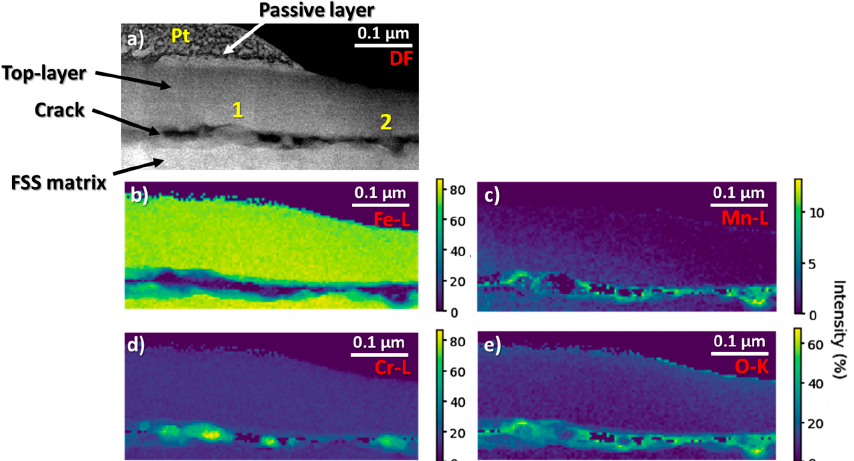
Figure 6. ( a ) Dark-field micrograph of the surface of a lamella of the FSS1 sample acquired simultane- ously as the EELS data. Quantification elemental maps (in at.%) for the ( b ) Fe, ( c ) Mn, ( d ) Cr, and ( e ) O elements.